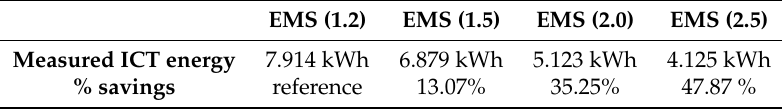
Table 4. Impact of relaxing service level agreement (SLA) on energy